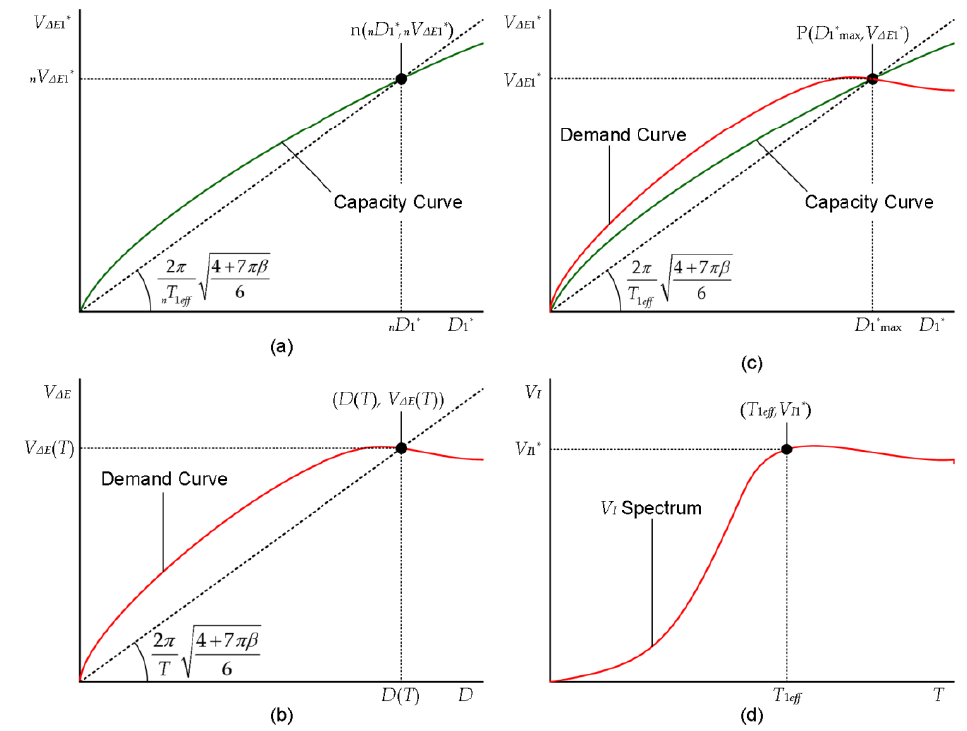
Figure 2. Schemes for the prediction of the peak and cumulative responses of the equivalent SDOF model: ( a ) capacity curve; ( b ) demand curve; ( c ) prediction of the peak equivalent displacement; ( d ) prediction of the cumulative input energy.